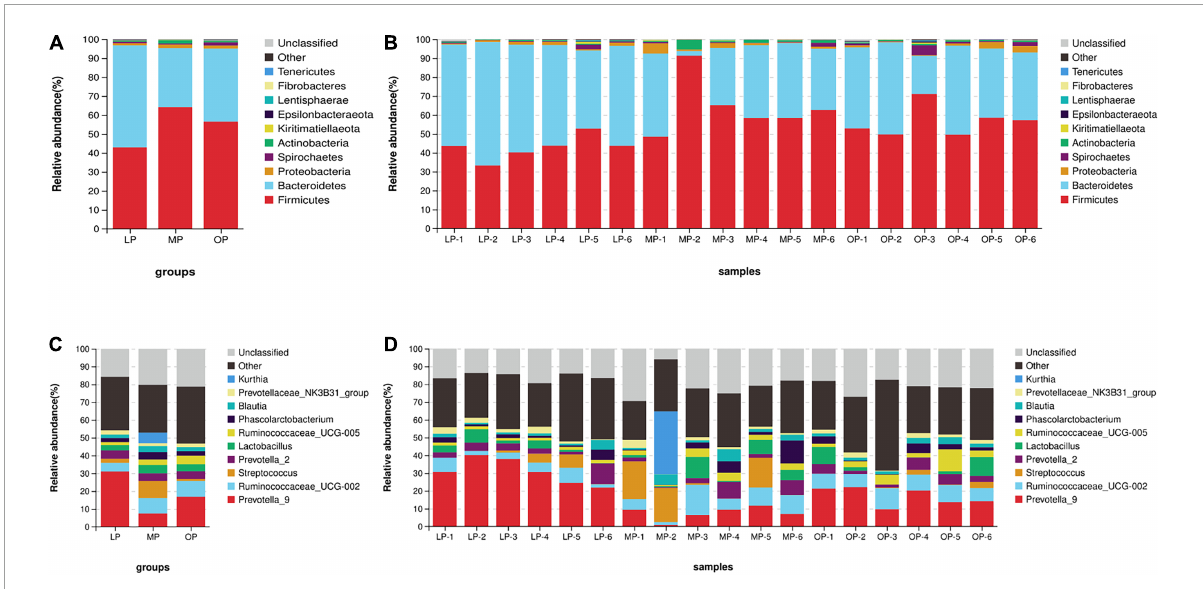
FIGURE2 The distribution of fecal microorganisms at the phylum levels at the respective stages of the menstrual cycle. The average of six samples (A) and each of the individual six samples at the phylum level (B) . The distribution of fecal microorganisms at the genus levels at the respective stages of the menstrual cycle. The average of six samples (C) and each of the individual six samples at the genus level (D)